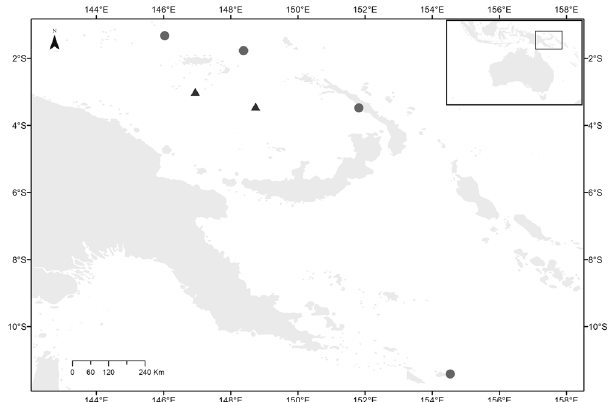
Figure 1. Sample locations for grey reef sharks C . amblyrhynchos (circles) and scalloped hammerhead S . lewini (triangles) in Papua New Guinea. Map created using ArcMap 10.2.1